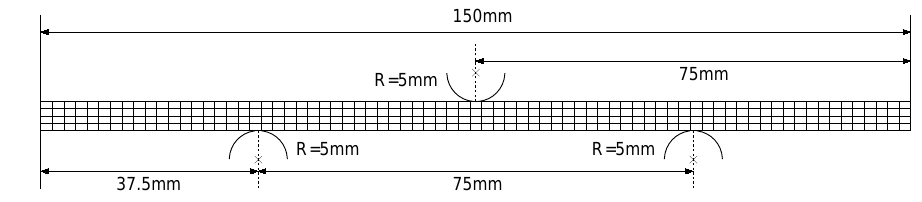
Figure 3. Geometry, dimension and mesh of the three-point bending